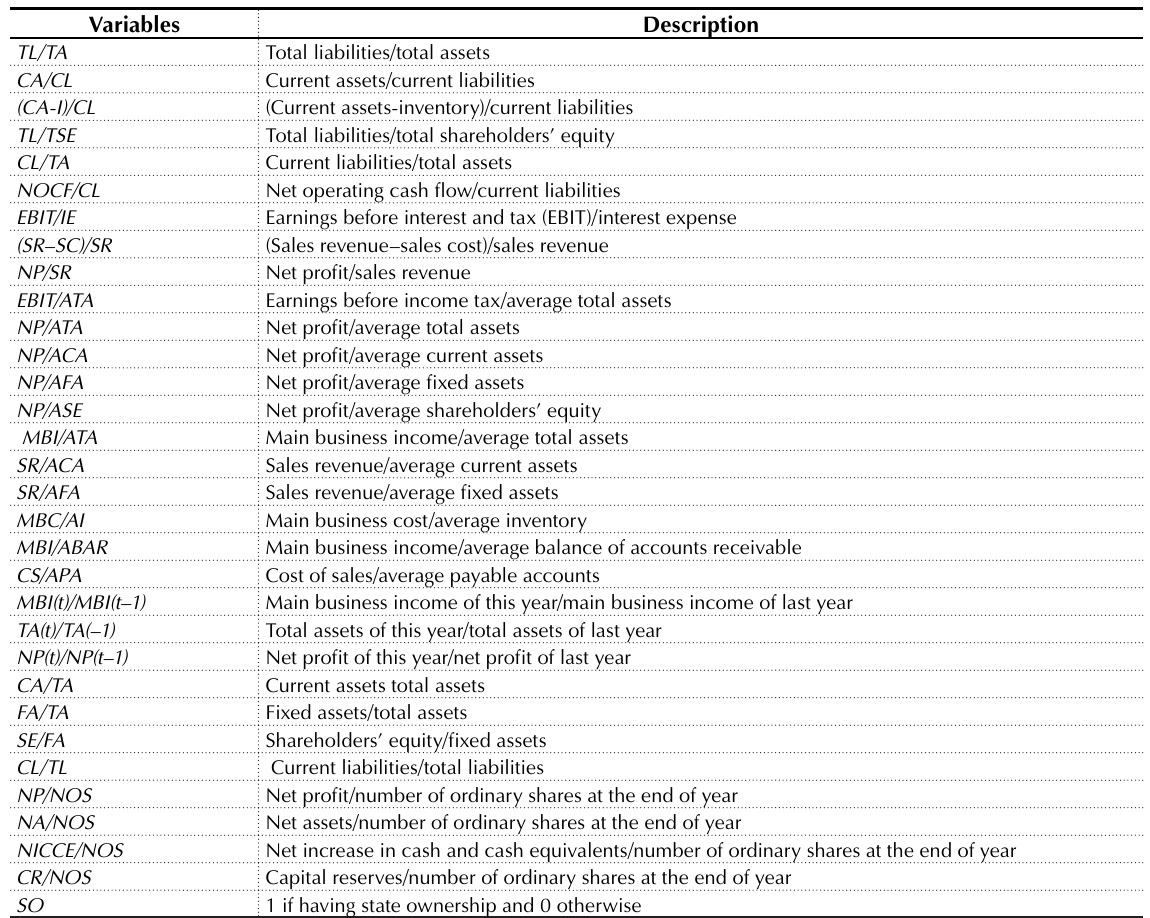
Source: Adapted from Geng, Bose, and Chen (2014).